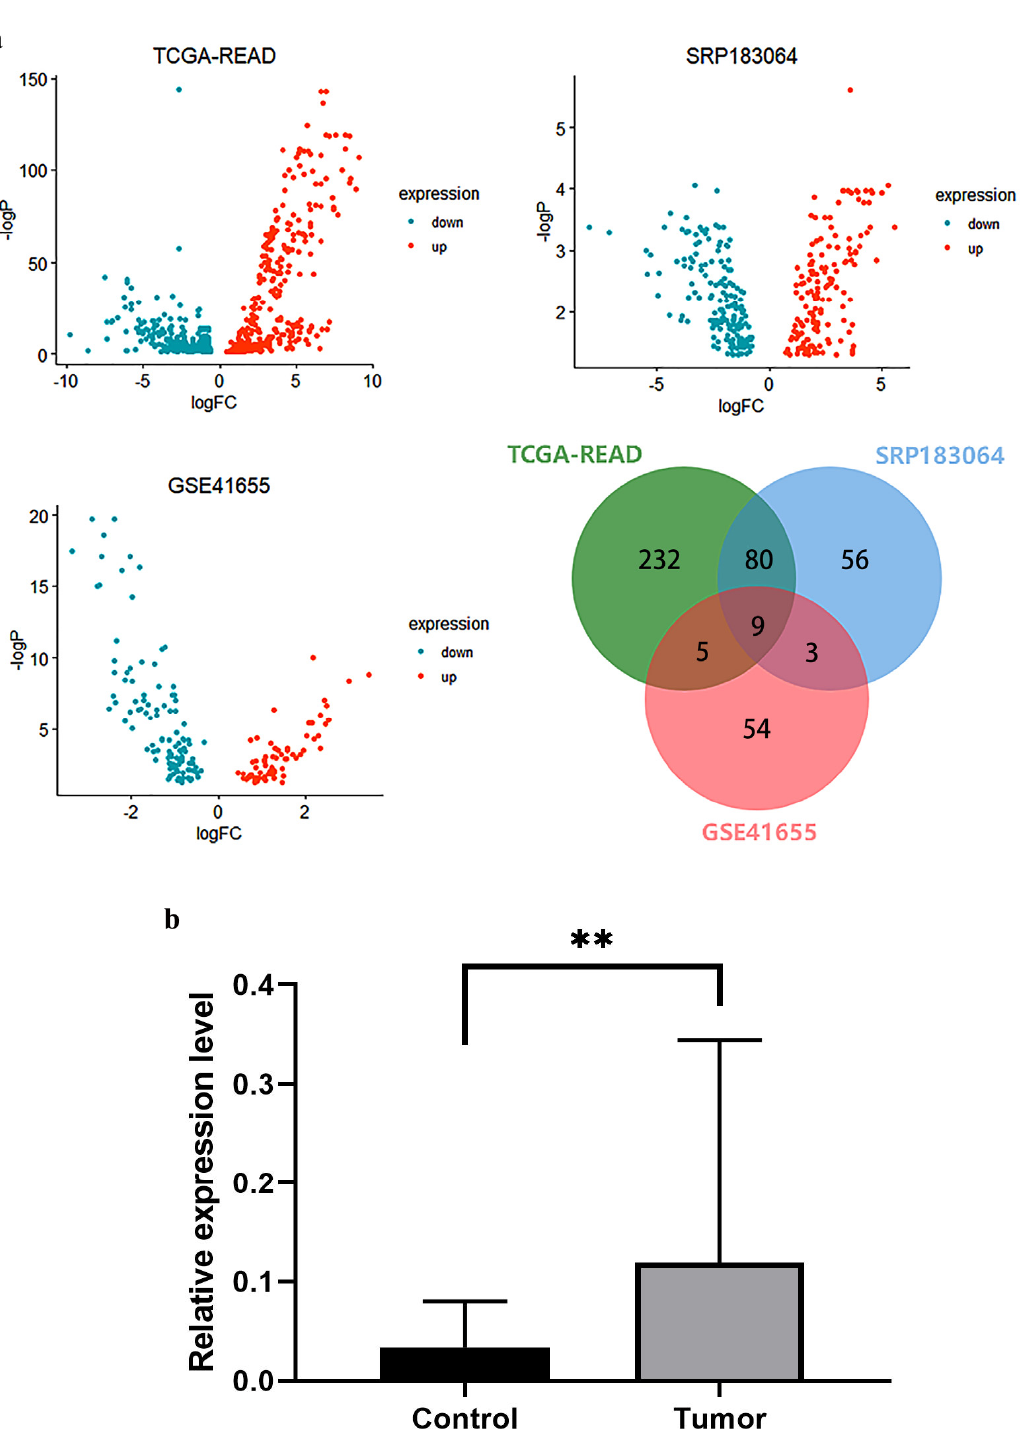
Figure 1. Bioinformatic analysis and clinical validation for preliminary screening of CRC biomarker. ( a ) Three datasets (TCGA − READ, SRP183064 and GSE41655) chosen for differential expression analysis and drawn by volcano plot (up- and downregulated miRNAs) and Venn diagram (upregulated miRNAs). ( b ) The relative expression level of miR-625-5p between tumor and adjacent tissues (5 cm away from the tumor). Tumor represents the tumor tissues and Control represents the adjacent tissues. All data are presented as mean ± SD, n = 24, ** p < 0.01.